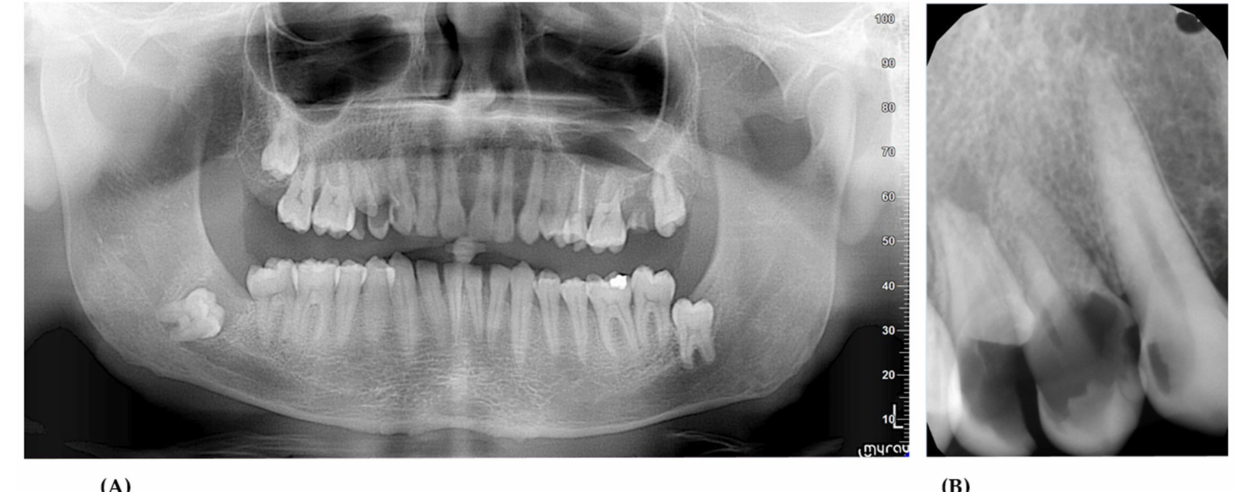
Figure 3. Orthopantomography ( A ) and radiovisiography ( B ) before surgical treatment.